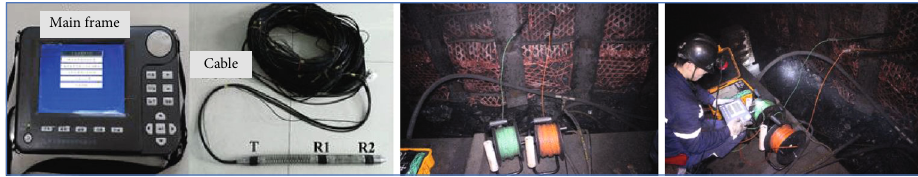
Figure 13: Ultrasonic logging with “ one transmitter and two receivers ” monitoring station.